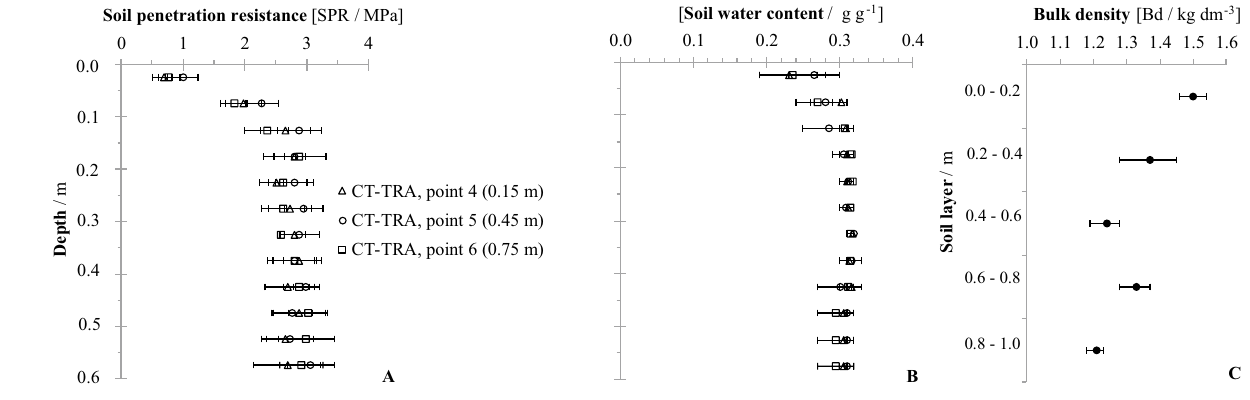
Figure 6. Soil penetration resistance ( A ) and soil water content ( B ) for the conventional tillage traffic lane (CT-TRA) at the three sampling positions (0.15, 0.45, and 0.75 m from planting row), and the average bulk density ( C ) at point 5. If the confidence intervals do not overlap, the differences are significant (p ≤